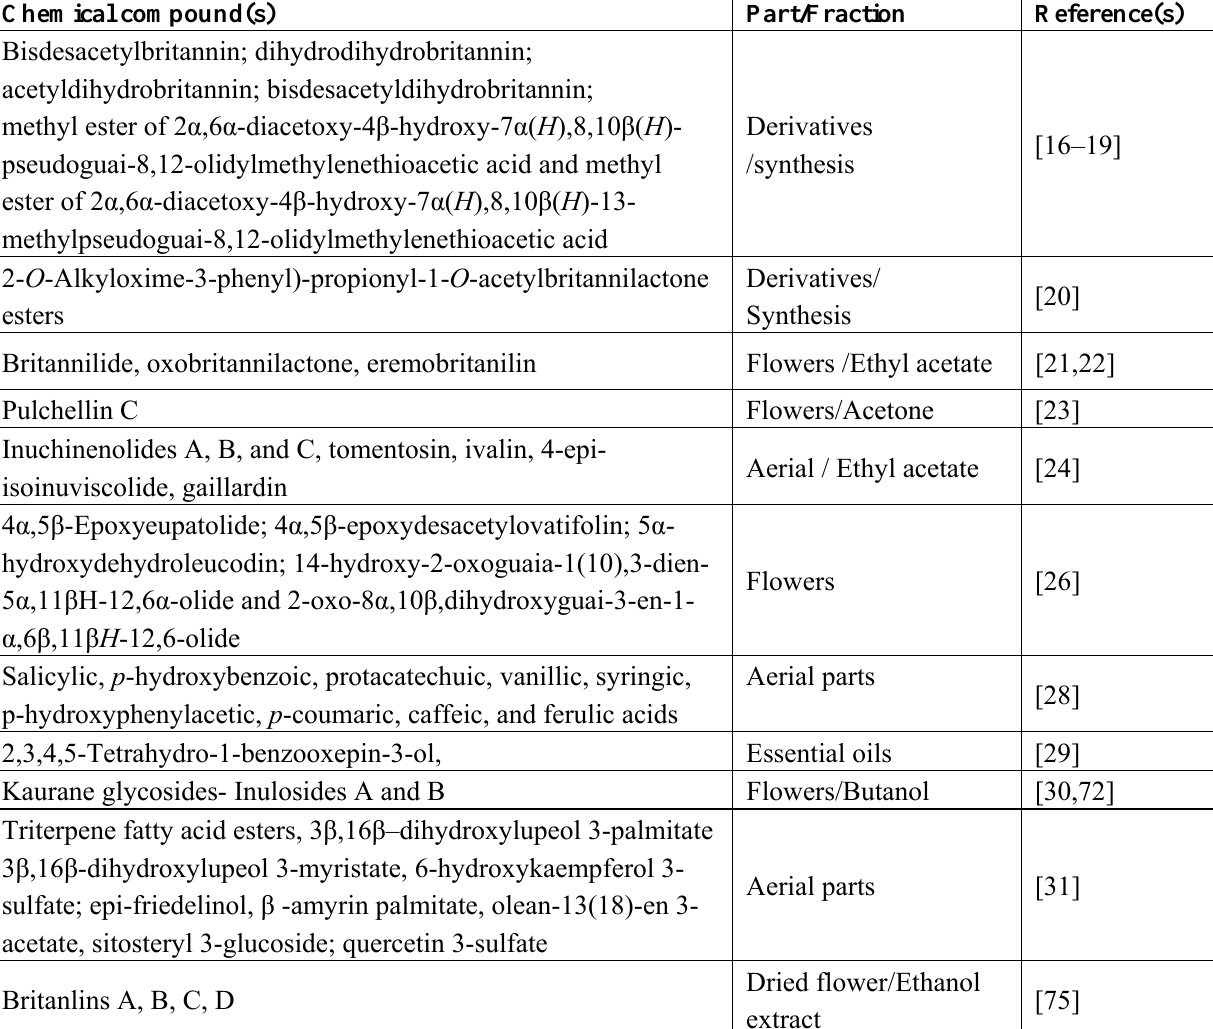
Table 1. Reported chemical constituents from I. britannica.